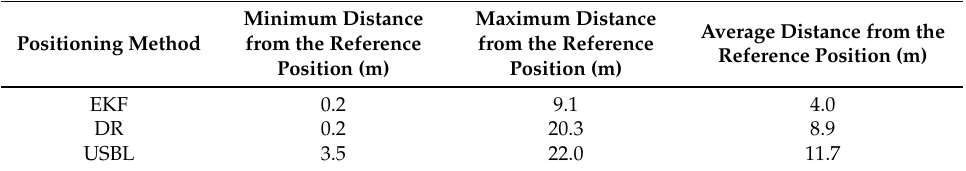
Table 11. Statistical parameters of positioning errors using EKF, DR methods and the USBL system (single passage).